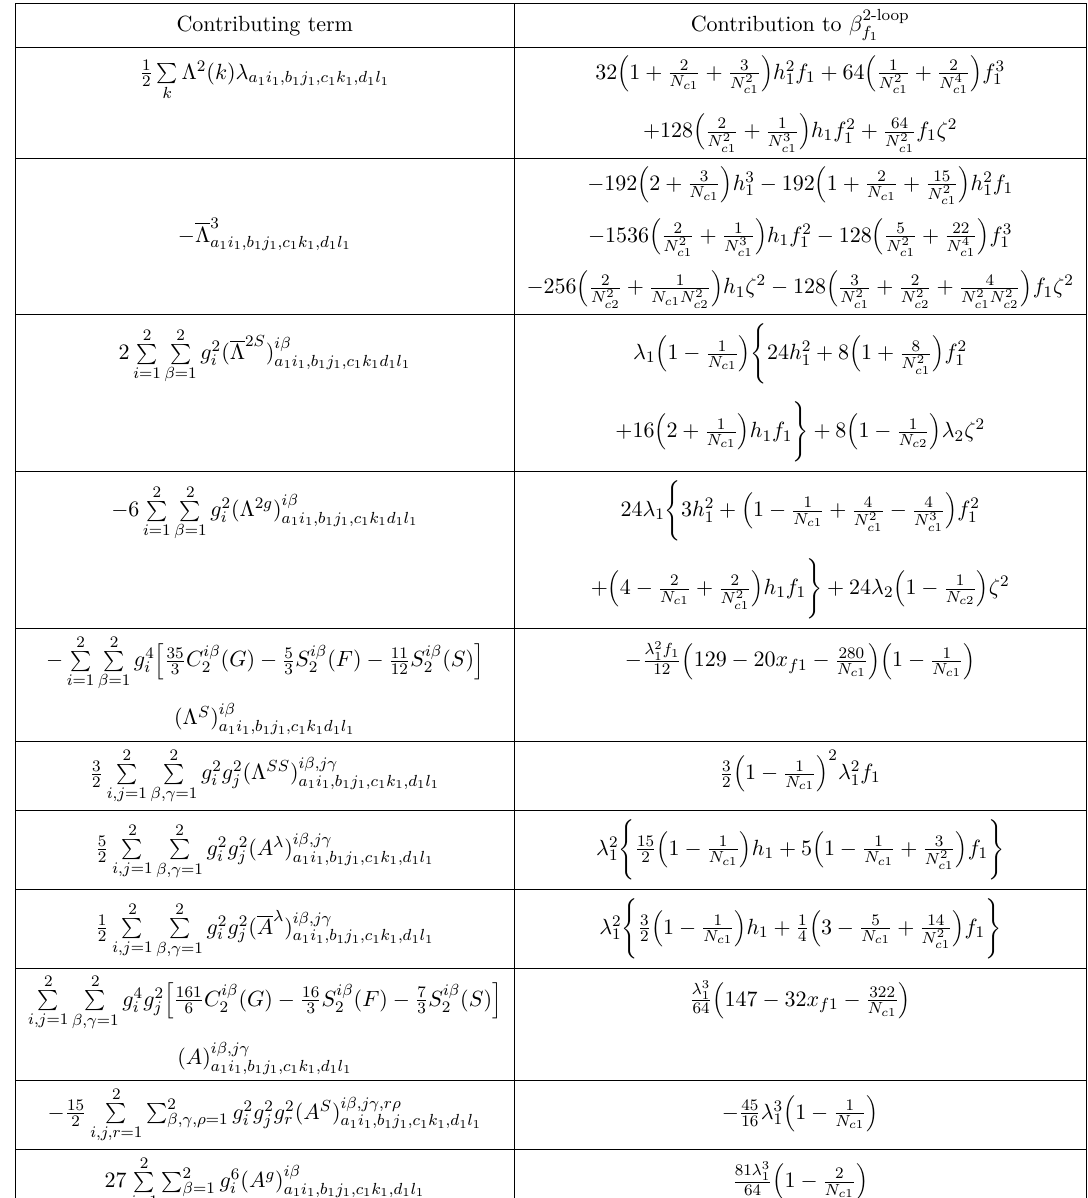
Table 4. Contribution of different terms to β 2-loop